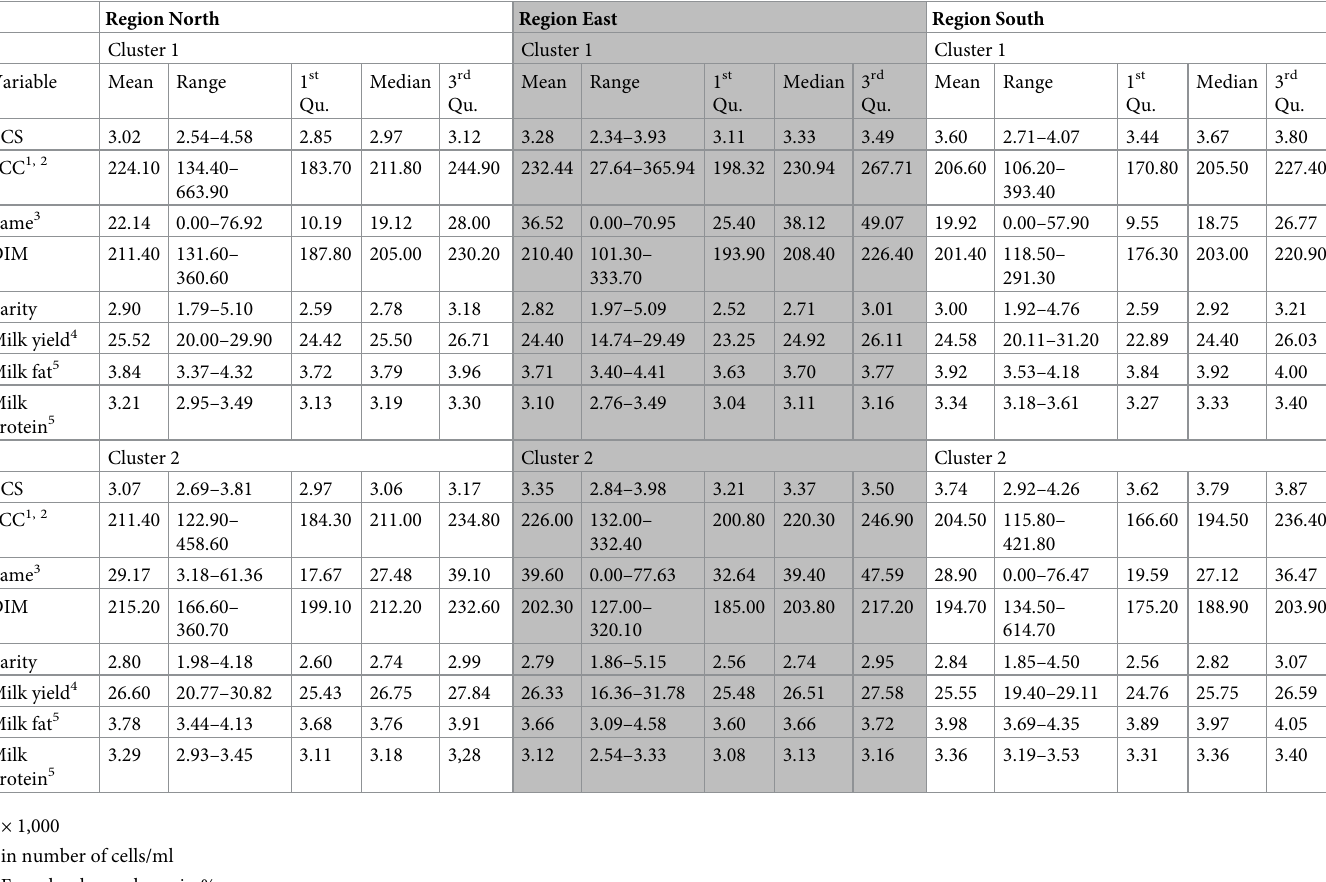
Table 4. Descriptive statistics of the O . ostertagi cluster analysis across study regions (continuous variables). Region North Region